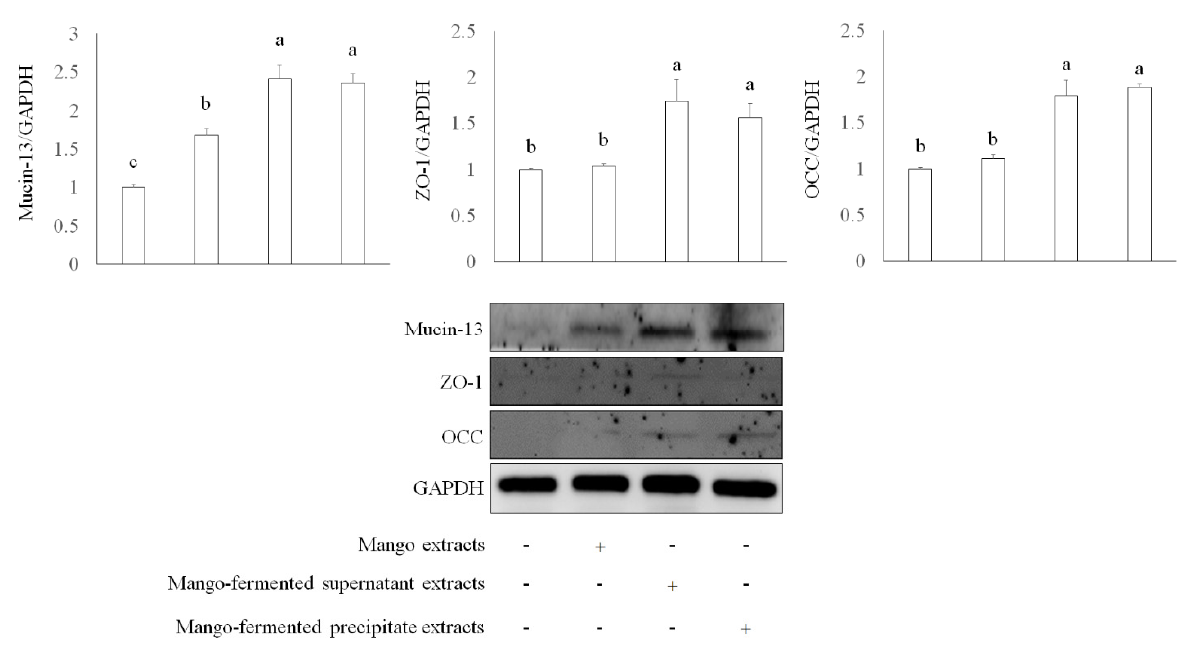
Figure 3. The intestinal protection of L. acidophilus BCRC14079-fermented mango on expressions of mucin-13, ZO-1, and OCC in differential Caco-2 cells. Data are shown as means ± SD ( n = 3). Significant difference was shown by various letters ( p < 0.05). Symbol + means this sample is added to the group, and symbol − means this sample is not added.